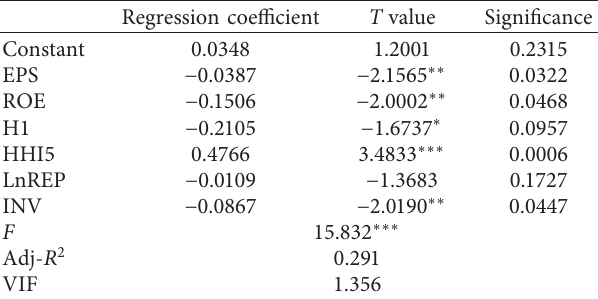
Table 5: Regression analysis of cumulative abnormal return. Regression coefficient T